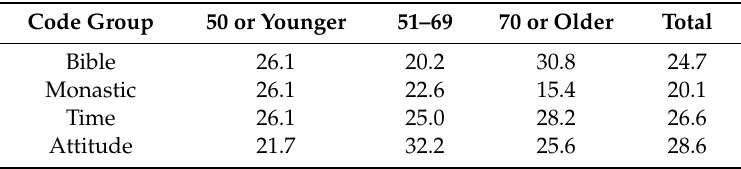
Table 8. Dimensions of reading—personal context—age.